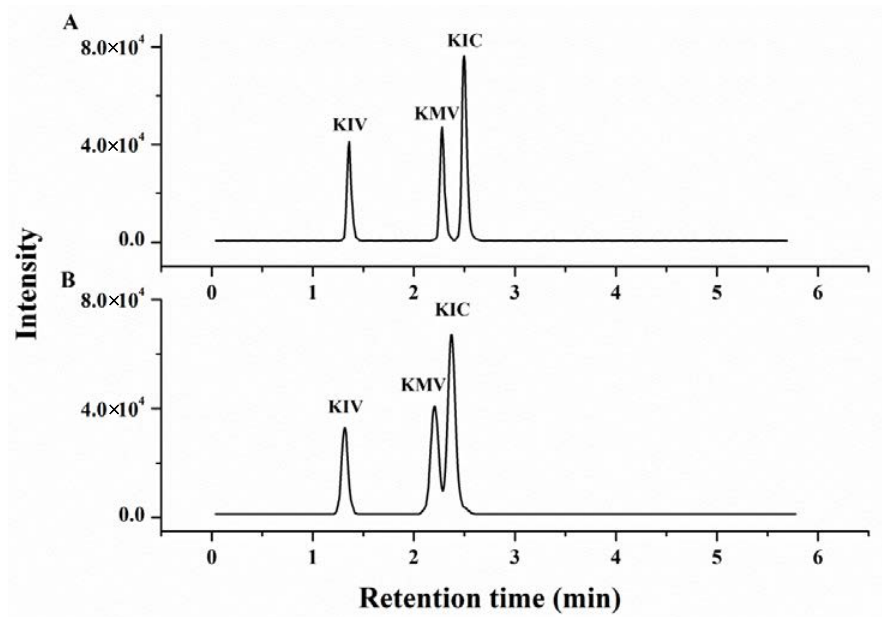
×××× Figure 1. Influence of different columns on the HPLC performance of the branched-chain keto acids (KIV: α -ketoisovalerate; KMV: α -keto- β -methylvalerate; KIC: α -ketoisocaproate) mixed standard solution (2.5 μmol/L for each compound): ( A ) Agilent Eclipse Plus C 18 column; ( B ) Waters BEH C 18 column. Figure 2. Intensity of 3 branched-chain keto acids (KIV: α -ketoisovalerate; KMV: α -keto- β - methylvalerate; KIC: α -ketoisocaproate) mixed standard solution (5 μmol/L for each compound) in different fragmentor (V).